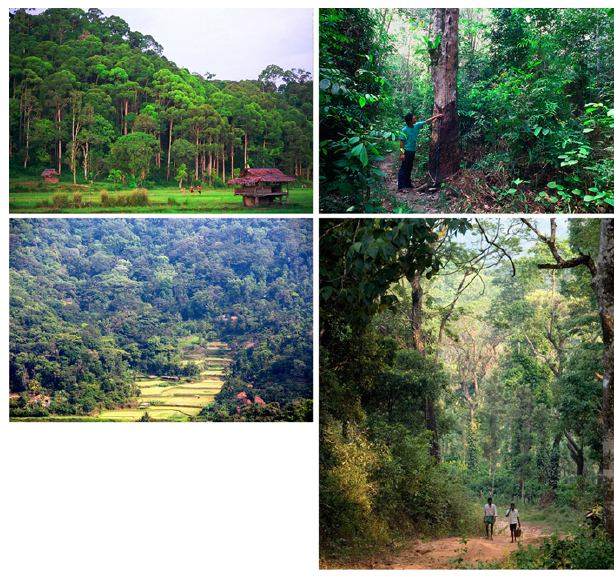
Fig. 2 . Rural forests: Agroforests in Indonesia (above) with damar (Shorea javanica) (left) and rubber (Hevea brasiliensis) (right), Agroforests in India with coffee (below)